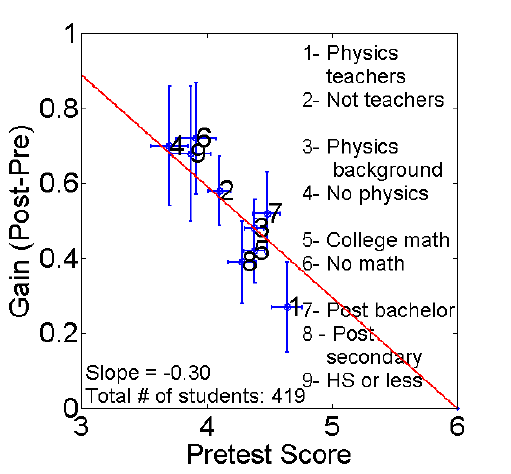
Figure 1 . The negative slope of the red line, constrained to go through the point (6,0), indicates the normalized gain that best fits the 419 students who answered all 6 force- related items on both pre and post tests. The mean pretest and gain scores, with standard errors, are also shown for various cohorts. “No math” indicates the cohort of students without college-level